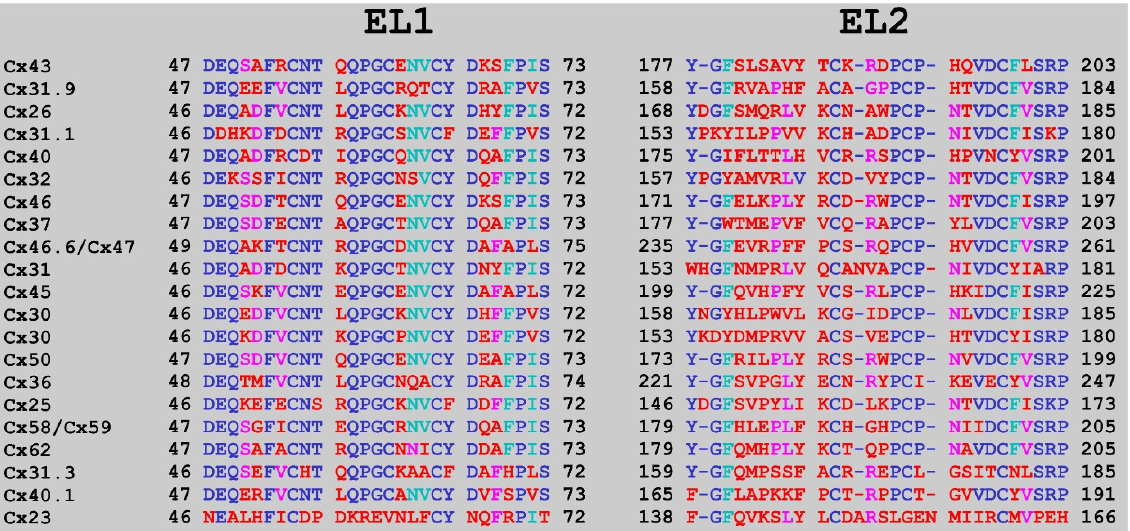
Figure 6. Alignments of extracellular cysteine-rich domain sequences of 21 Cx family members . Left: EL1; Right: EL2. The alignment has been calculated by Clustal [35] implemented in the Jalview multiple sequence alignment program [36]. Letters are colored according to the percentage of the residues in each column that agree with the consensus sequence (https://www.jalview.org/help/html/colourSchemes/pid.html. Only the residues that agree with the